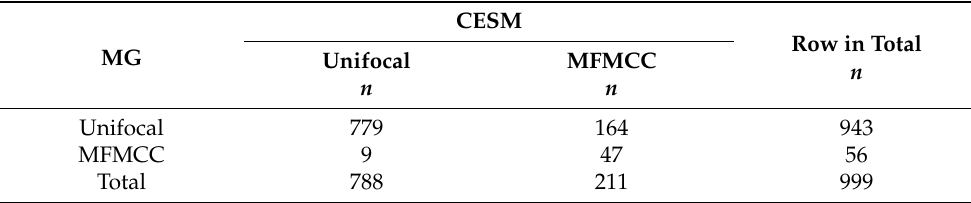
Table 1. The share of multifocal-multicentral breast cancers (MFMCC) in MG and